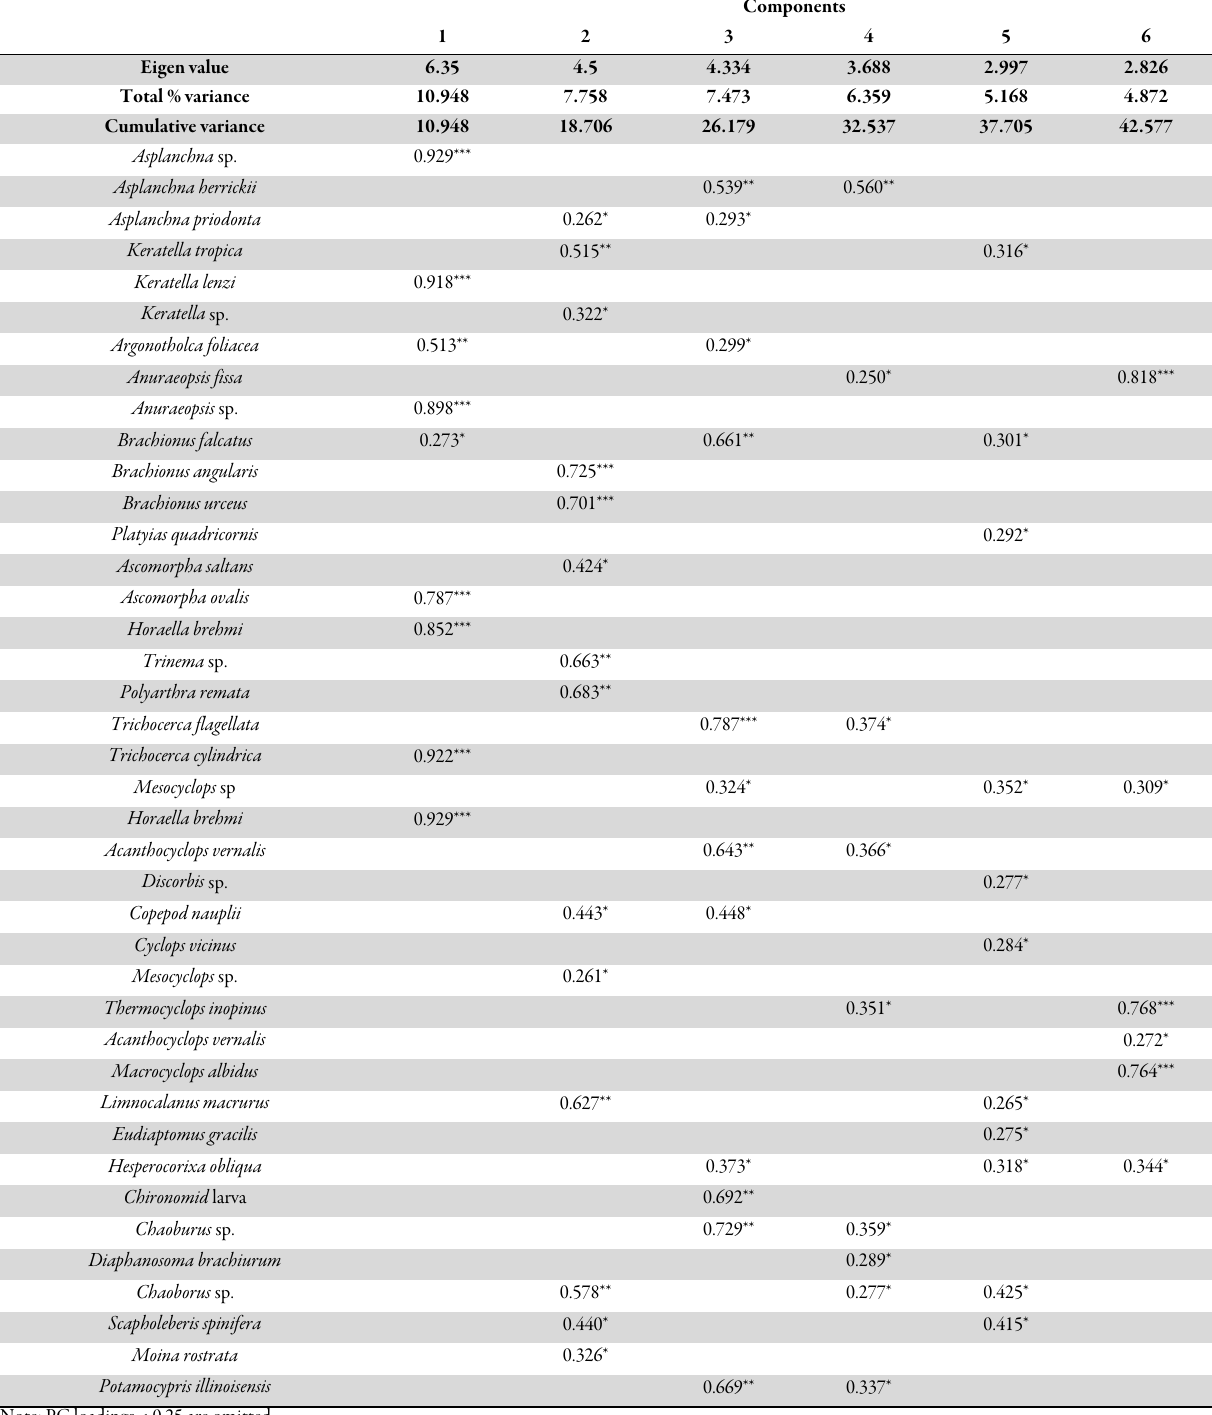
Table 7. Principal component analysis for the zooplankton species based on their abundance